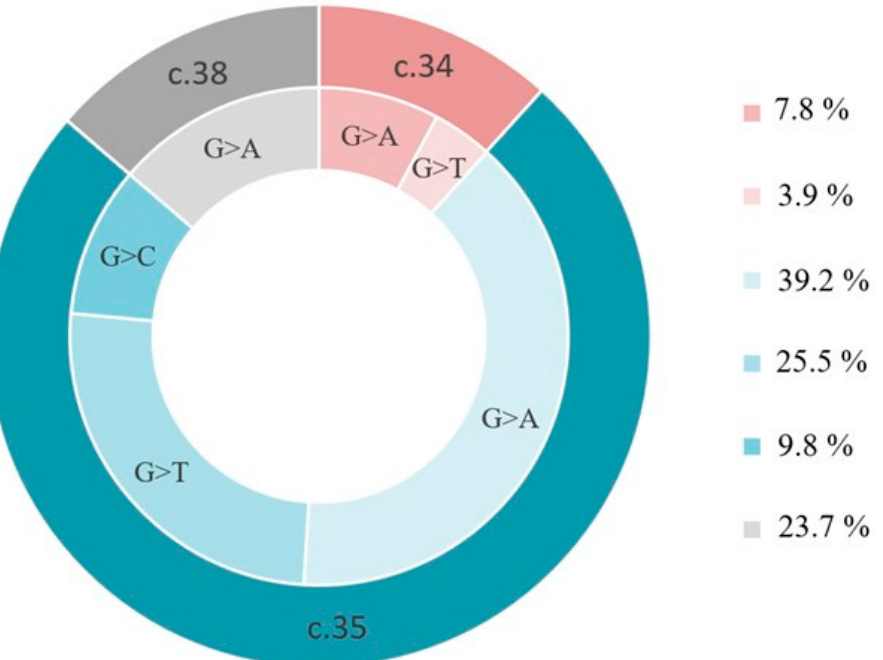
Figure 4. KRAS mutations distribution detected in our patient cohort ( n = 50).